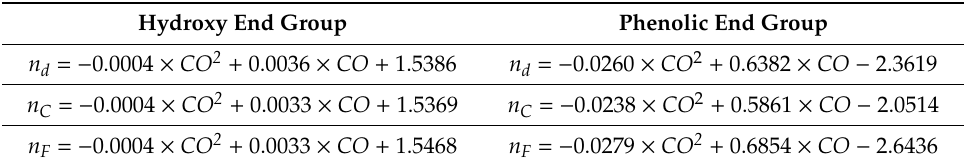
Figure 7. Relation between weight percentage of the carbonyl groups CO and Abbe number v d. Table 3. Correlation of the refractive indices of the hydroxy end group and the phenolic end group of DNDM-PC and CO, which is derived from D